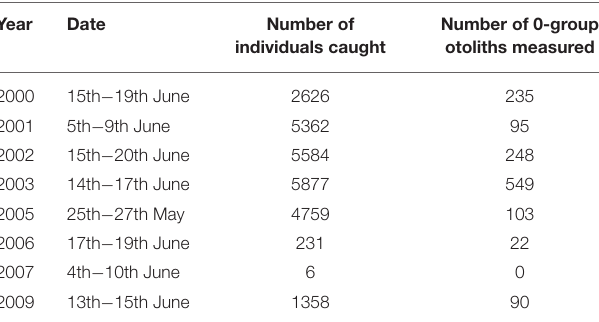
TABLE 1 | The number of sandeels caught and aged from pelagic